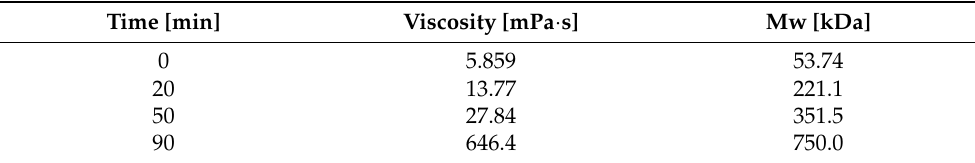
Table 1. Changes in viscosity and molecular weight (MW) in different time points following the enzymatic polymerization of the